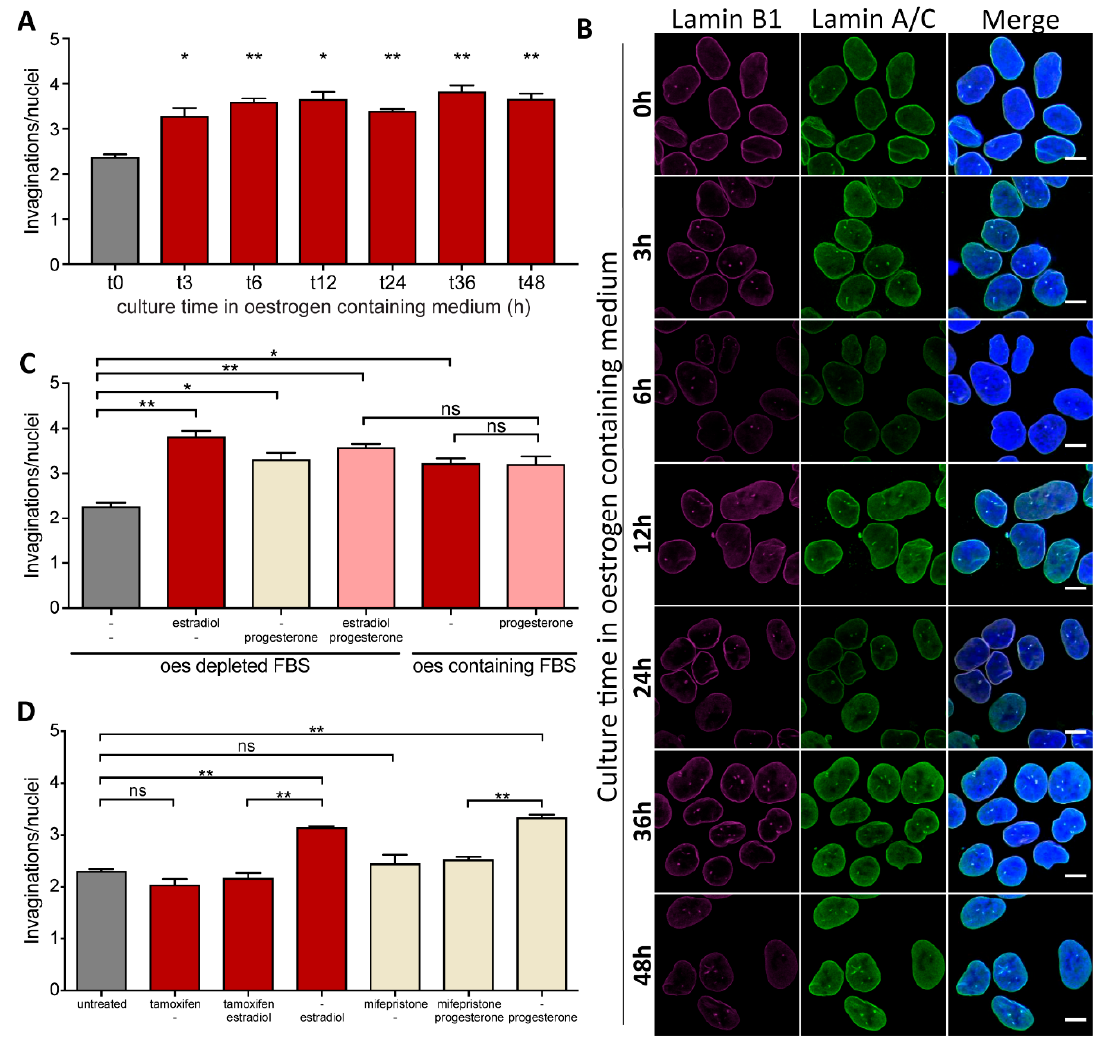
Figure 2. Formation of NR tubules in endometrial cells is hormone responsive. ( A ) NR formation time-course in Ishikawa cells in response to oestrogen. An F-test rejects the null hypothesis (slope = 0) between t0, t3 and t6 ( p = 0.005) while this null hypothesis cannot be rejected for later time-point (t 12 to t 48) ( p > 0.5). ( B ) Immunostained Ishikawa cells imaged at different intervals after addition of oestrogen to the culture medium. Scale bar 10 µm. ( C ) NR abundance in Ishikawa cells in response to estradiol and/or progesterone treatment in medium containing either oestrogen-stripped FBS ( oes trogen-depleted FBS) or regular FBS ( oes trogen-containing FBS). ( D ) NR abundance in Ishikawa cells treated for 72 h with estradiol or progesterone and their respective antagonists. Data from 2 independent experiments, 100 nuclei each; mean ± SEM; * for p -value < 0.05, ** for p -value < 0.01, ns for non-significant.